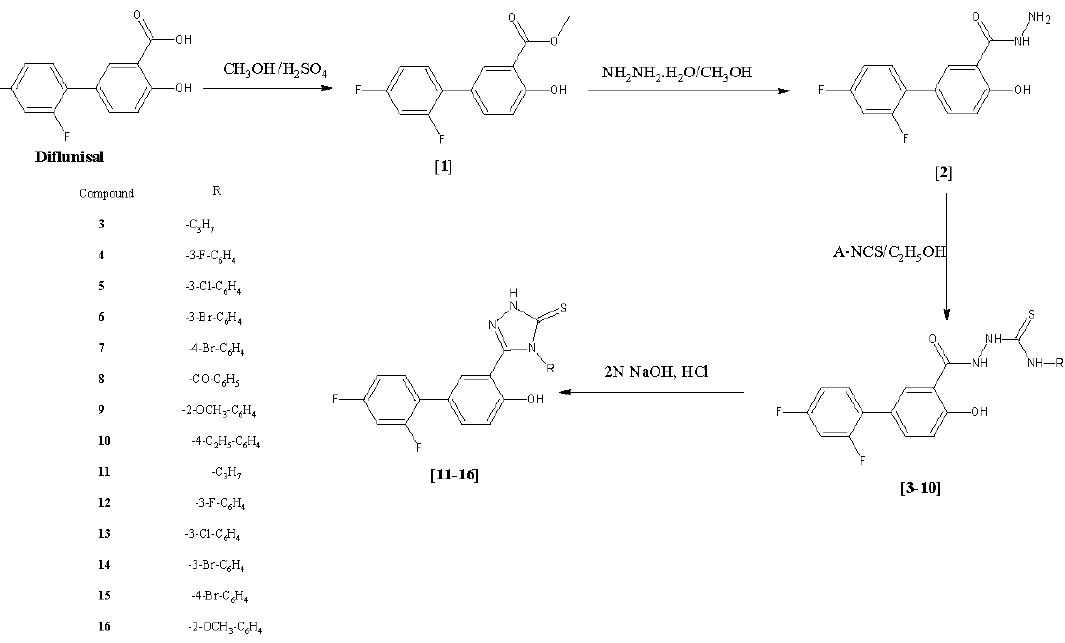
Figure 1. Synthetic route to newly synthesized diflunisal thiosemicarbazides ( 3 – 10 ) and 1,2,4-triazole-3-thiones 11 – 16 .